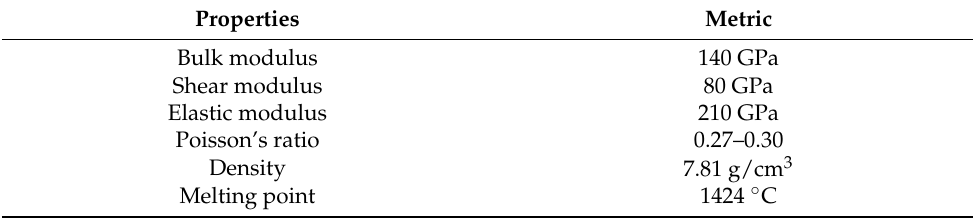
Table 2. Mechanical property of SAE 52100 alloy steel